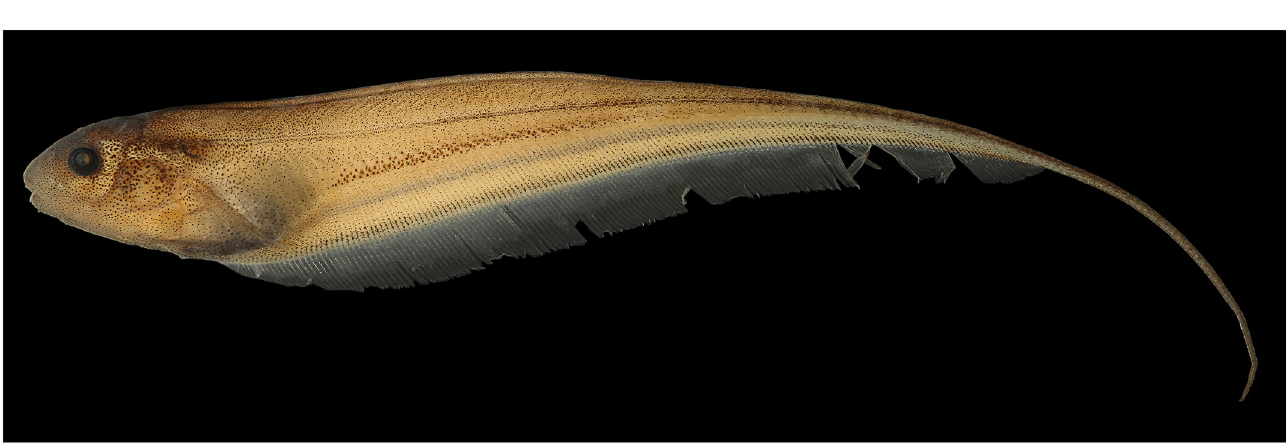
Fig 4. Lateral view of Eigenmannia sirius , MCP 41099, paratype, 75.6 mm L EA , Mato Grosso, Brazil, rio Mutum, tributary of rio Juruena, rio Tapajo´s basin.